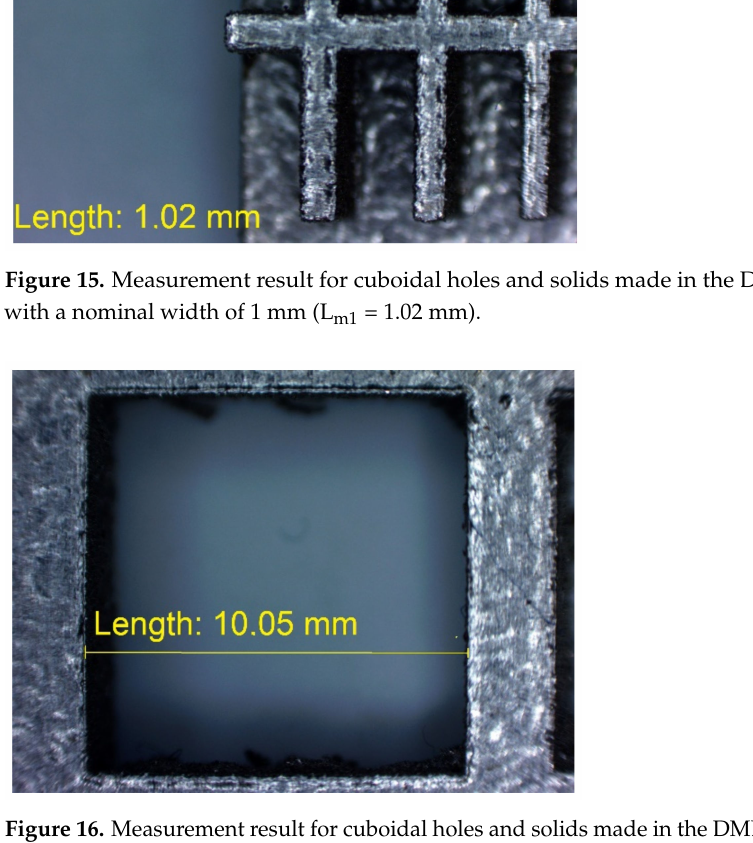
Figure 16. Measurement result for cuboidal holes and solids made in the DMLS technology: cuboidal hole with a nominal width of 10 mm (L dl = 10.05